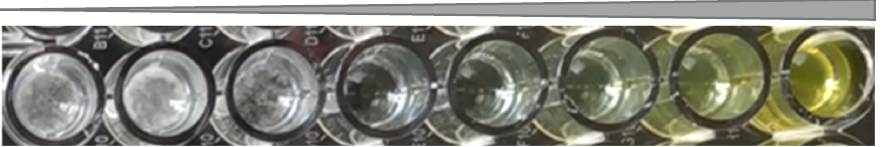
Figure 4. Anti-oomycete activity of hop extracts and sub-extracts on P.infestans germination. ( A ) Half maximal inhibitory concentration (IC 50 ) values. ( B ) Inhibitory activity of DSE of leaves (from 0 to 1000 mg.L − 1 ) after six-day incubation.Different letters represent significant differences.